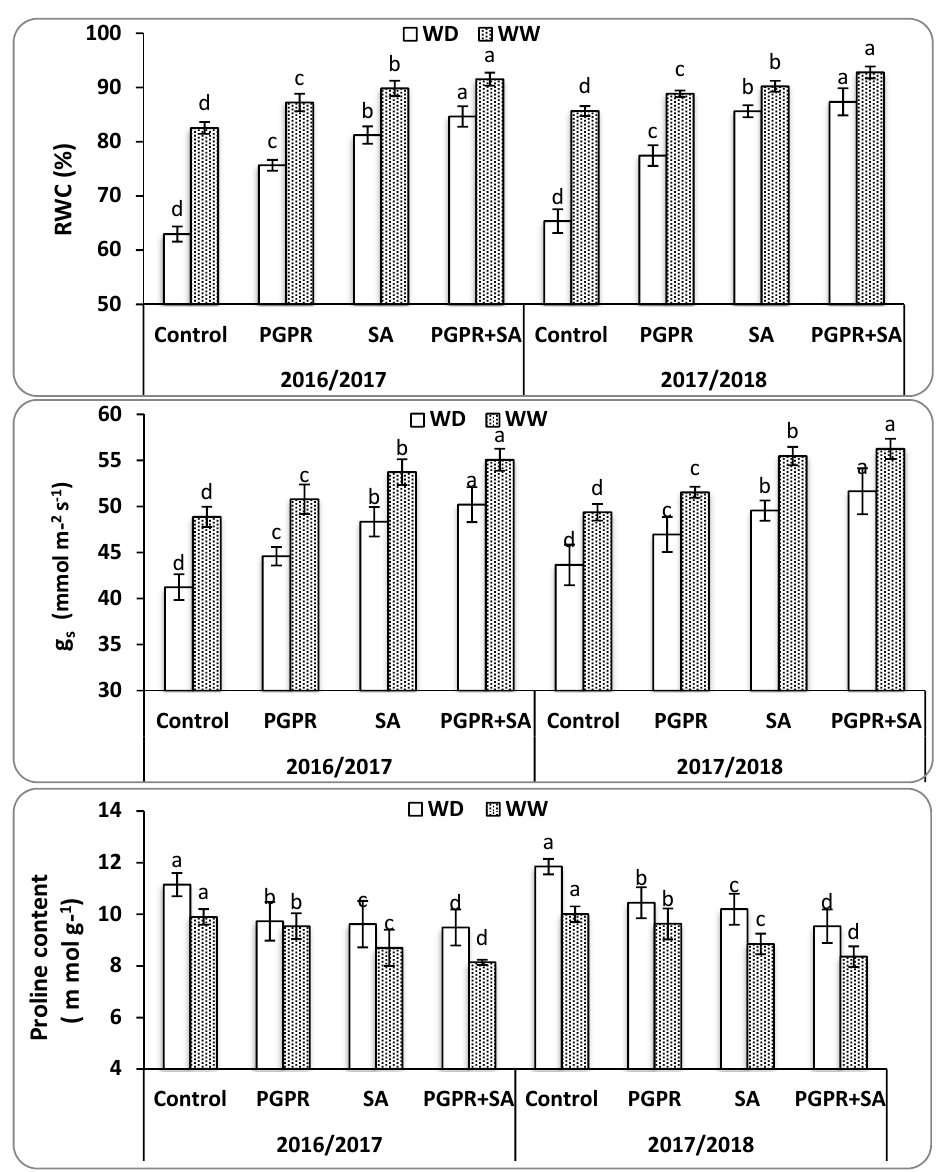
Figure 3. Effect of soil and foliar treatments on relative water content, stomatal conductance (g s ), and proline content of wheat plants under water deficit conditions during two growing seasons 2016/2017 and 2017/2018. WD = water deficit (two irrigations), WW = well-watered (four irrigations). The data are the mean ± SE of three replicates; Mean values designed by the same letter in each column are not significant according to Duncan’s Multiple Range